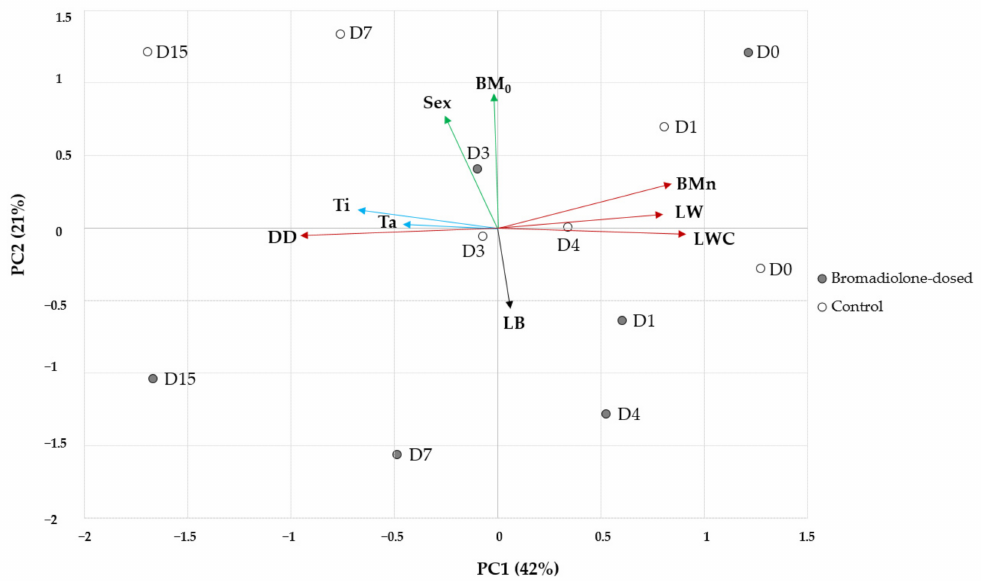
Figure 4. Principal component analysis (PCA) biplot of the common kestrel experiment. Vectorsrepresent: biologicalvariables(sexandbodymassonday0, BM 0 ), weathervariables(i.e.,internal temperature, Ti, and ambient temperature, Ta), decomposition variables (i.e., days of decomposition, DD, body mass during necropsy, BMn, liver weight, LW, and liver water content, LWC), and liver bromadiolone concentration (LB). The points represent individual birds from the bromadiolone-dose (grey) or control group (white), and D0-D15 indicates the days of decomposition.